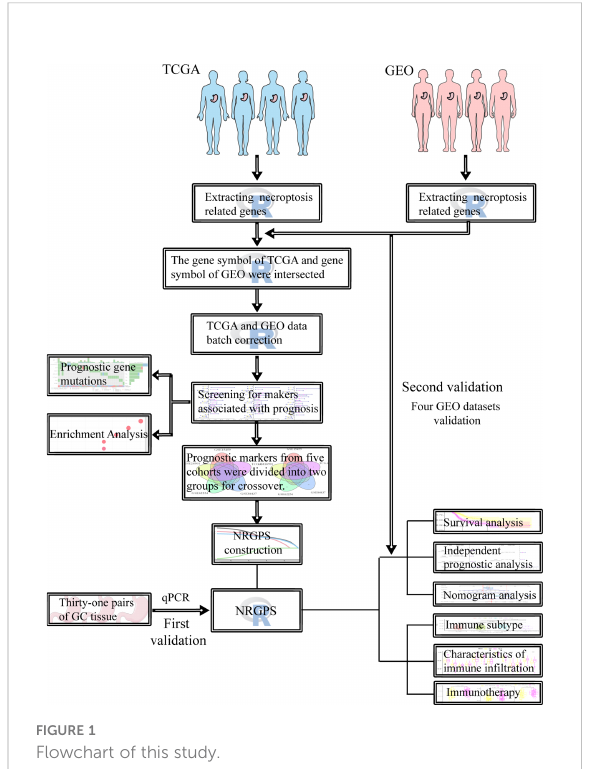
FIGURE 1 Flowchart of this